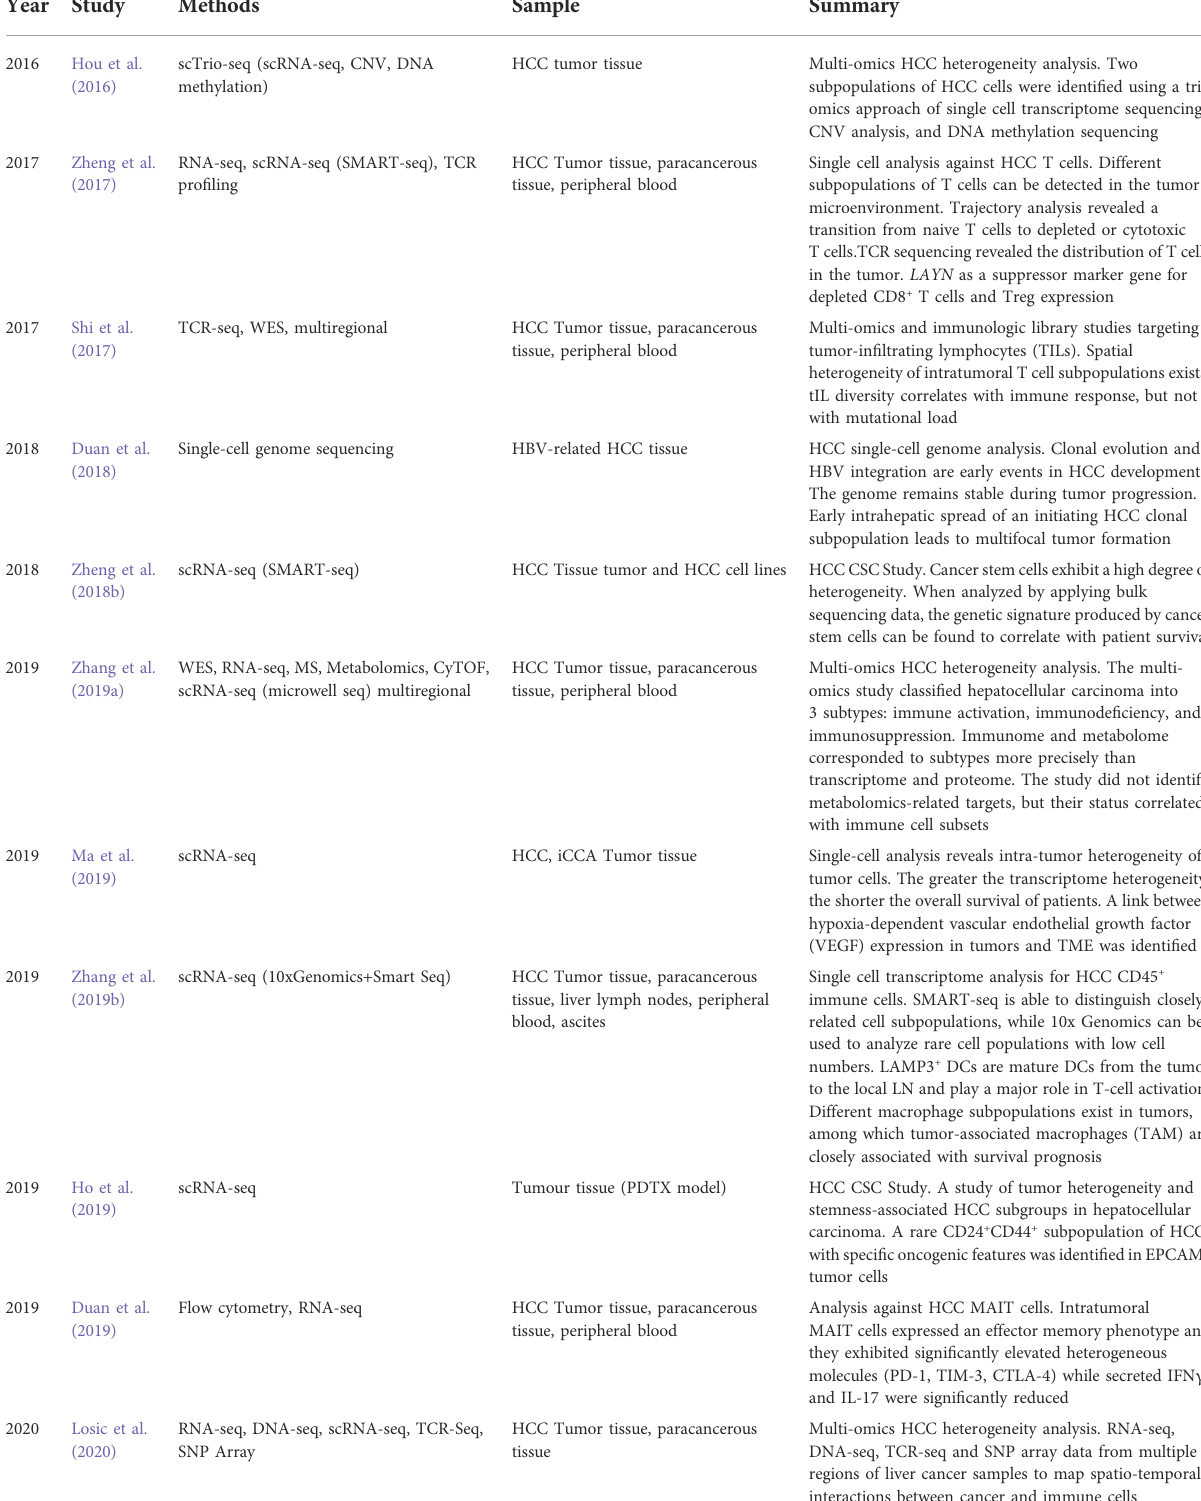
TABLE 5 Overview of recent studies on the tumor microenvironment of hepatocellular carcinoma at the single-cell